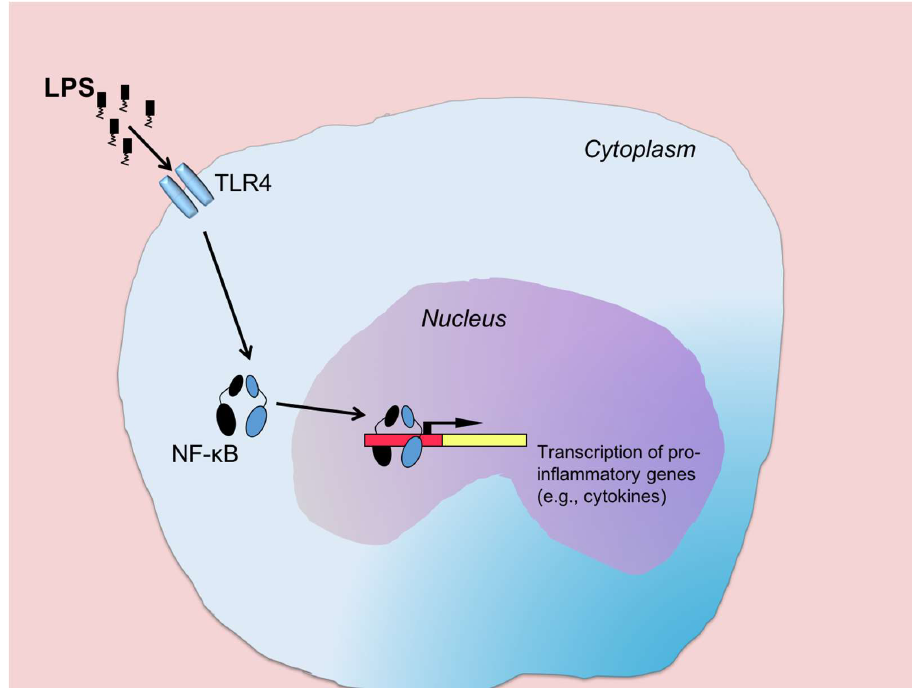
Figure 2. LPS from Gram-negative bacteria bind and activate TLR4 which leads to the activation and translocation from the cytoplasm of the transcription factor NF-κB. Inside the nucleus, NF-κB initiates the transcription of a wide variety of pro-inflammatory genes, e.g., those encoding for pro-inflammatory cytokines.